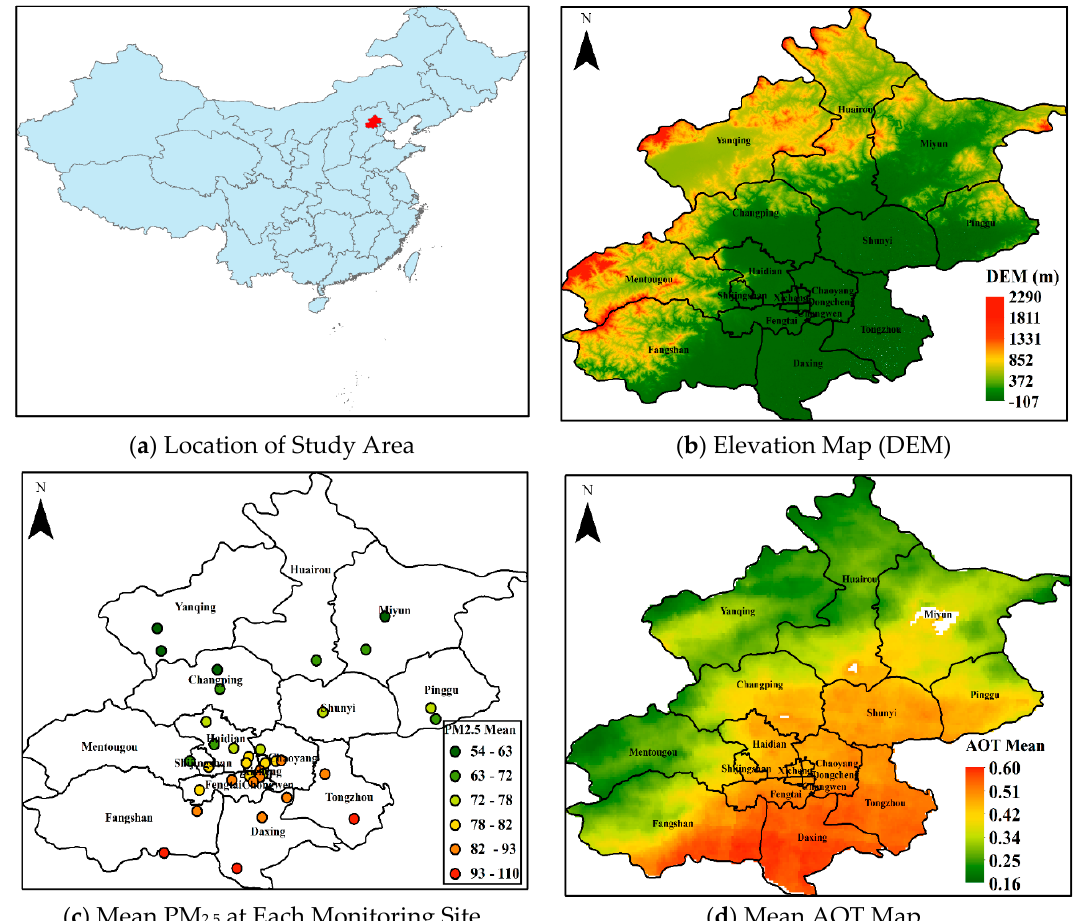
Figure 1. ( a ) Location of the study area (the red polygon on the map); ( b ) An elevation map (DEM—Digital Elevation Model) shows that the study area is surrounded by mountains in the west, north, and northeast; ( c ) The 24 h PM 2.5 average ( μ g/m 3 ) for each site during 2013–2017, classified into six levels and represented by different colors; ( d ) The spatial distribution of average 1 km Multi-Angle Implementation of Atmospheric Correction (MAIAC) aerosol optical thickness (AOT) during 2013–2017, with white color denoting water areas. The boundaries of 16 Beijing districts are shown in black lines.